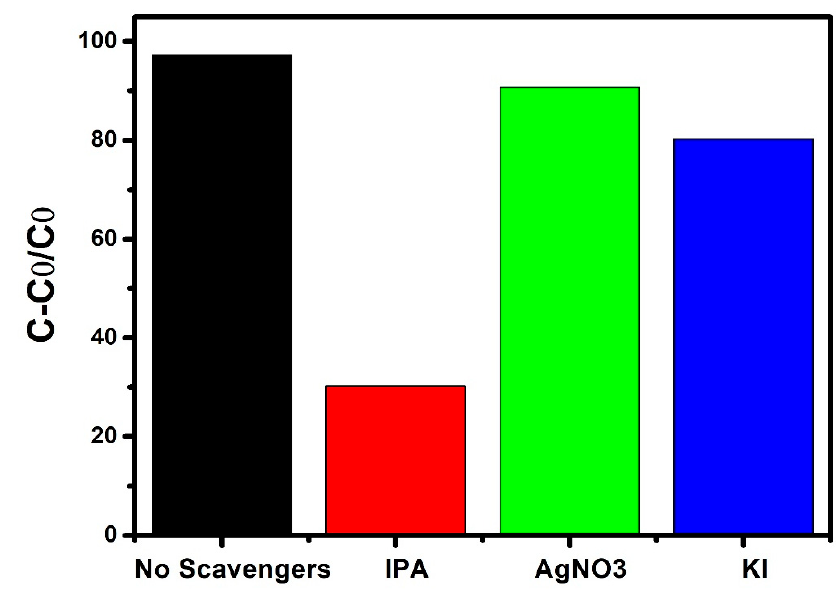
Figure 9. Phototcatalytic degradation mechanism of caffeine.